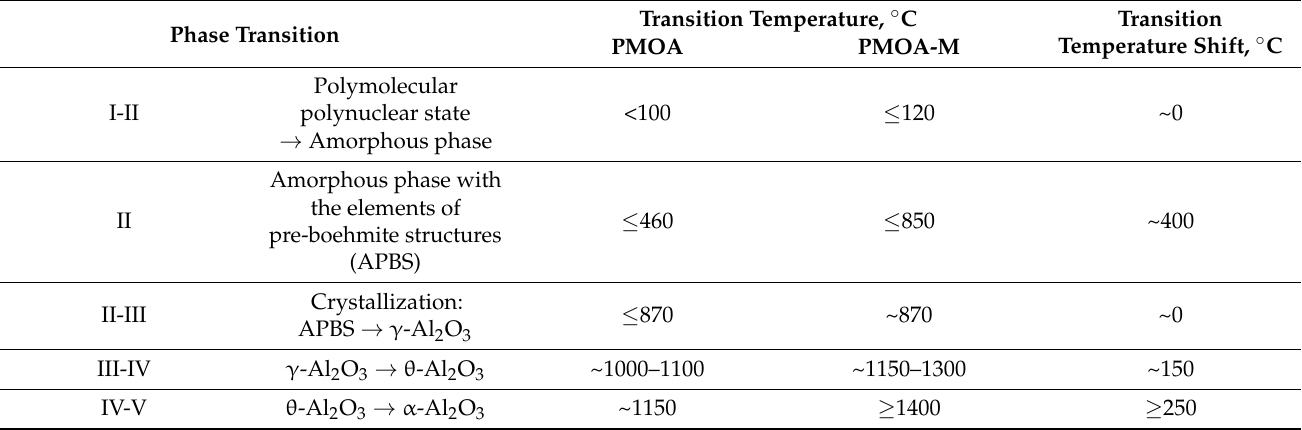
Figure 5. Effect of the annealing in air at the temperature of 1400 °C for 4 h on morphology of the samples: SEM images of ( a ). PMOA, and ( b ). PMOA-M.